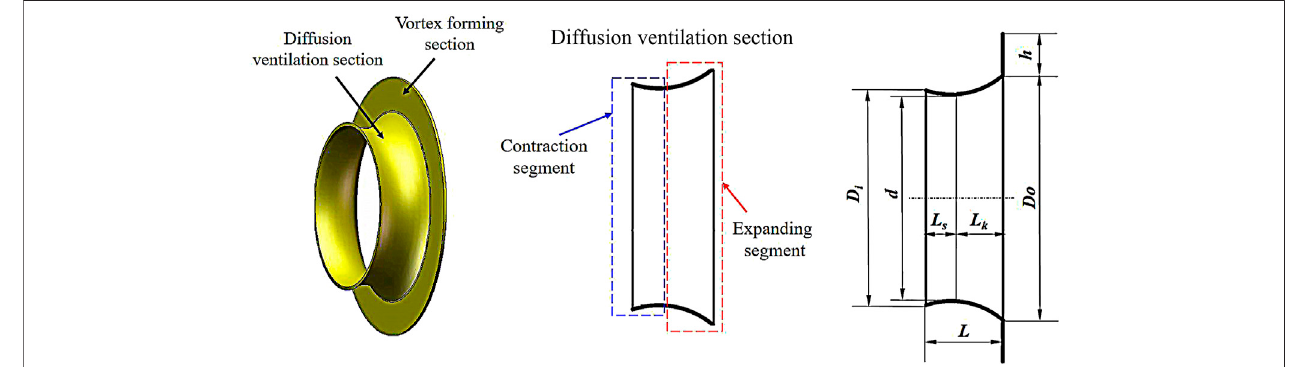
FIGURE 2 | Geometry model of a wind concentrator.